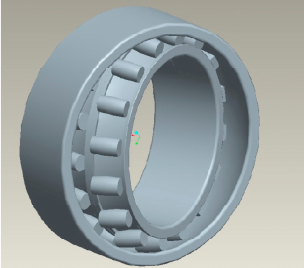
Figure 1. Double ‐ row spherical roller bearing (short for SRB). Figure 1. Double-row spherical roller bearing (short for